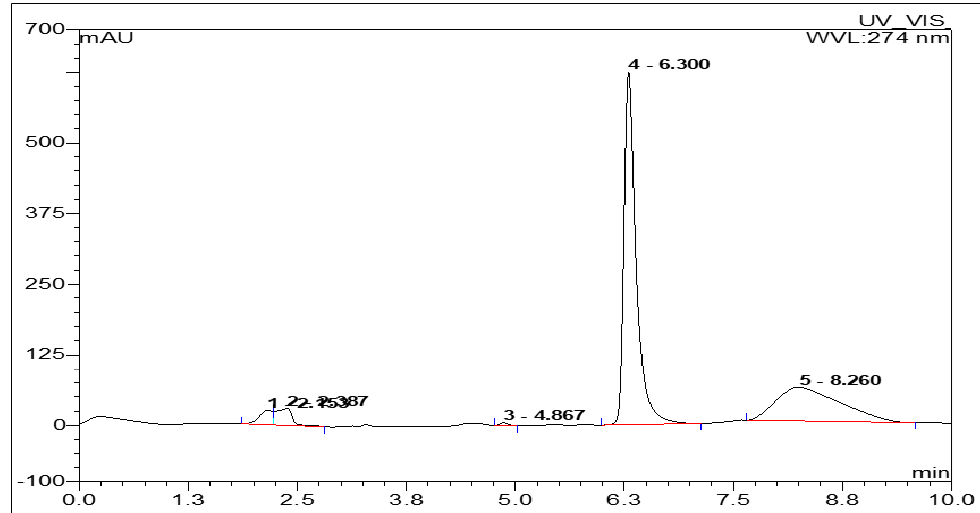
Figure 1. The HPLC chromatogram of caffeine. Enduro C-18G. (250 mm × 4.6 mm) column was used with methanol: water (37:63) mobile phase, the rate 1.0 mL/min and the DAD detector wavelength was set at 274 nm. Table 2. The caffeine content in coffee bean samples from three districts.